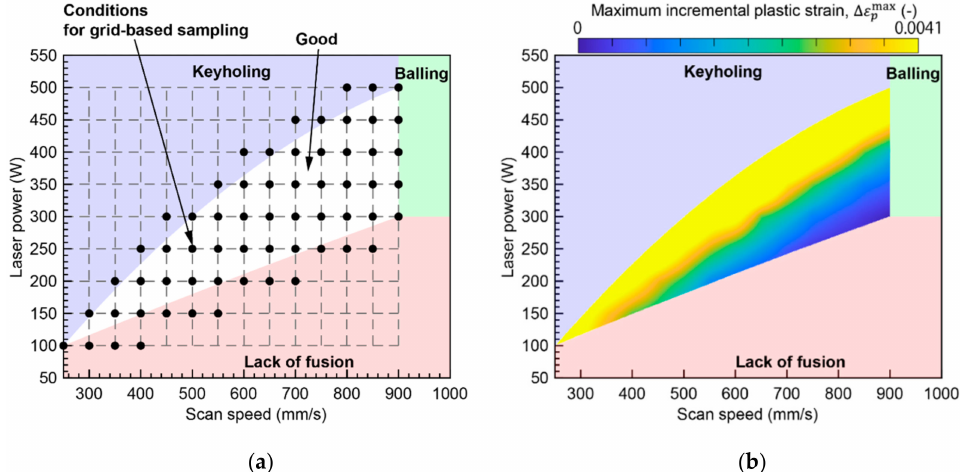
Figure 11. Laser irradiation conditions for grid-based sampling and maximum incremental plastic strain distribution in the good track region: ( a ) laser irradiation conditions for grid-based sampling; ( b ) maximum incremental plastic strain in the good track